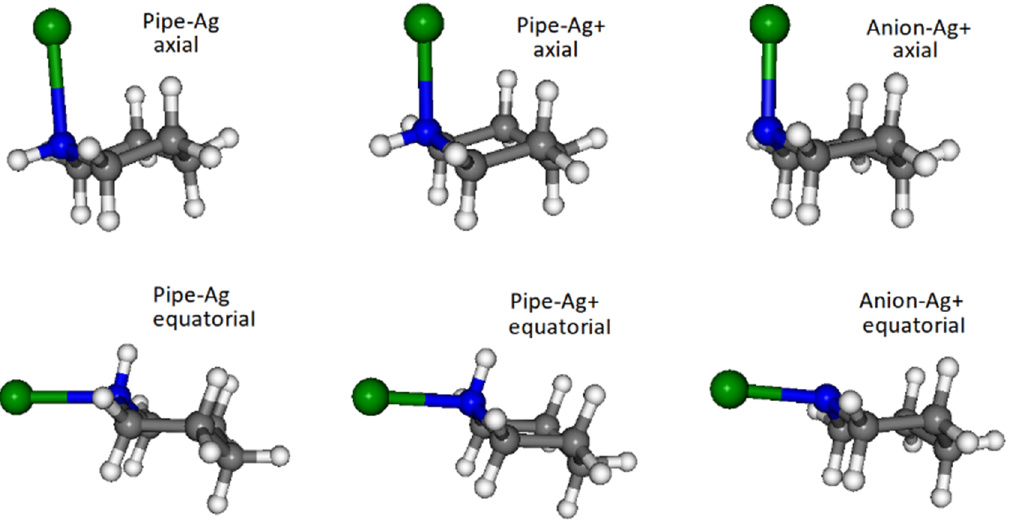
Figure 3. Piperidine/silver model complexes. Colors are standard CPK default, apart from the silver atom/ion which is depicted in green for better visualization.